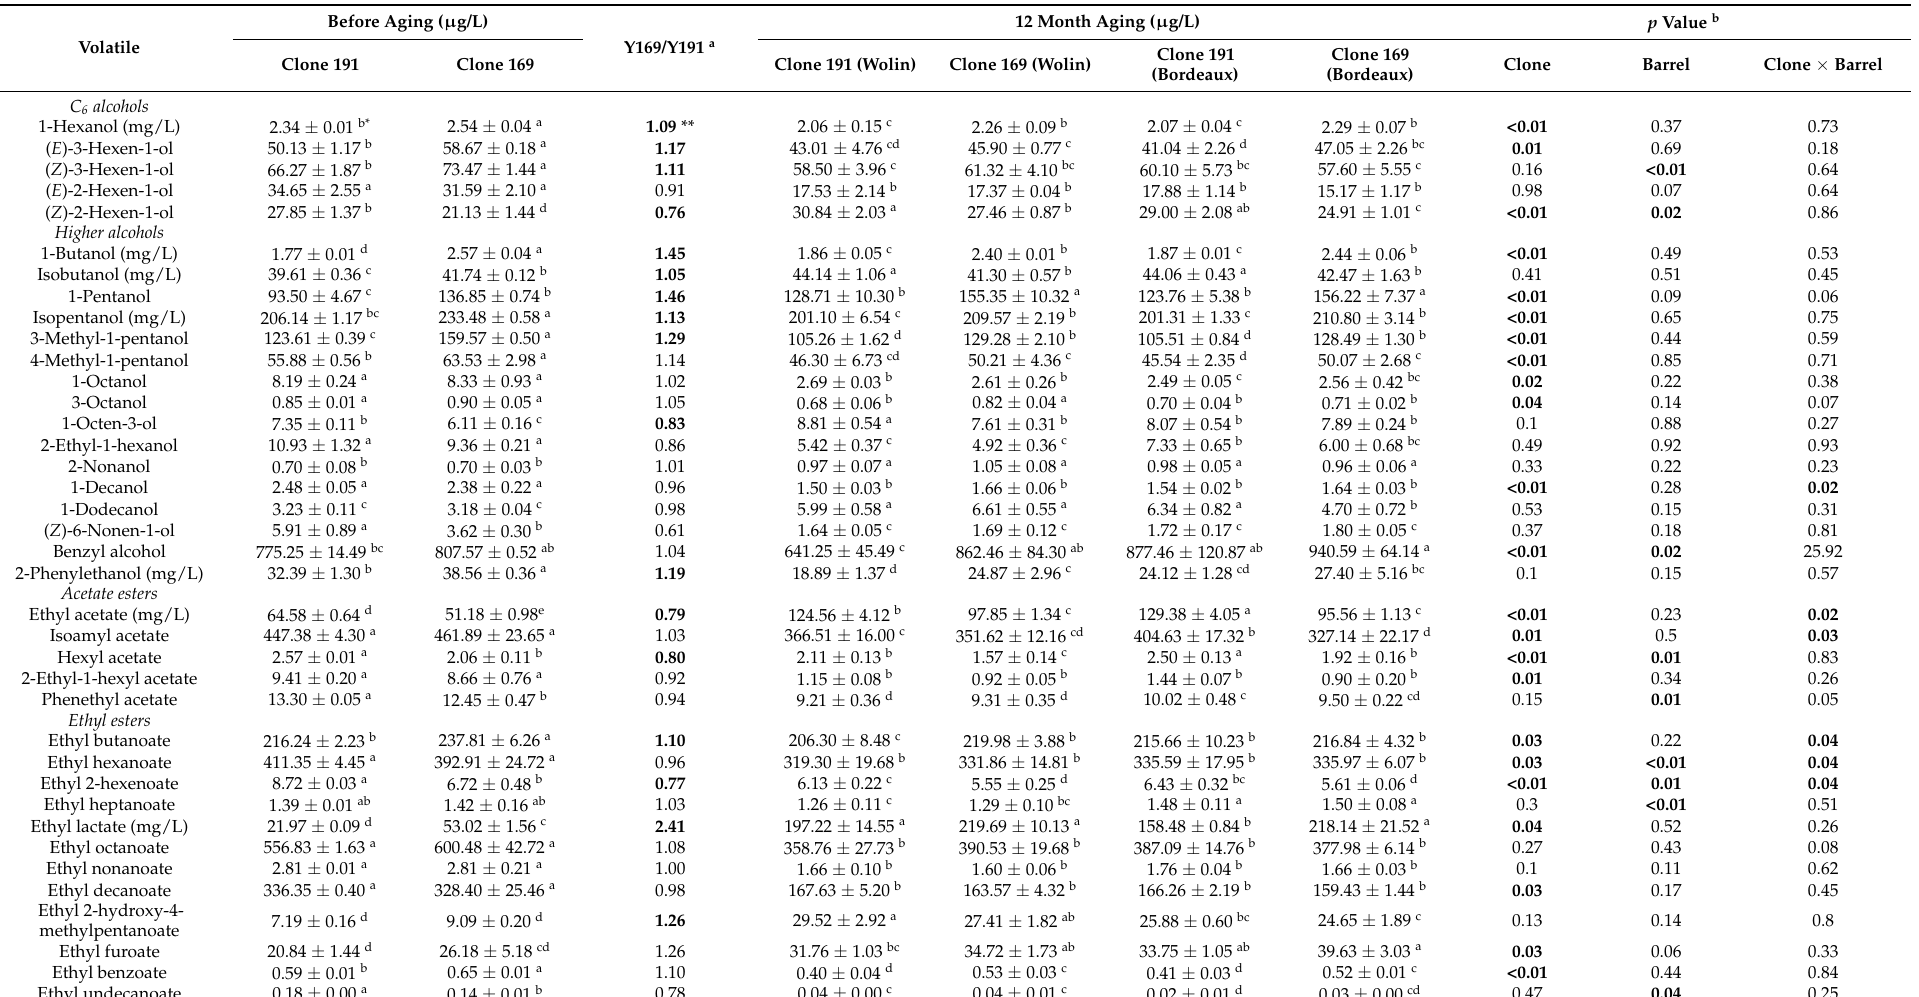
Table 2. Concentration of individual volatile compounds in wine made of clone 169 and 191 before and after 12 months of aging determined by